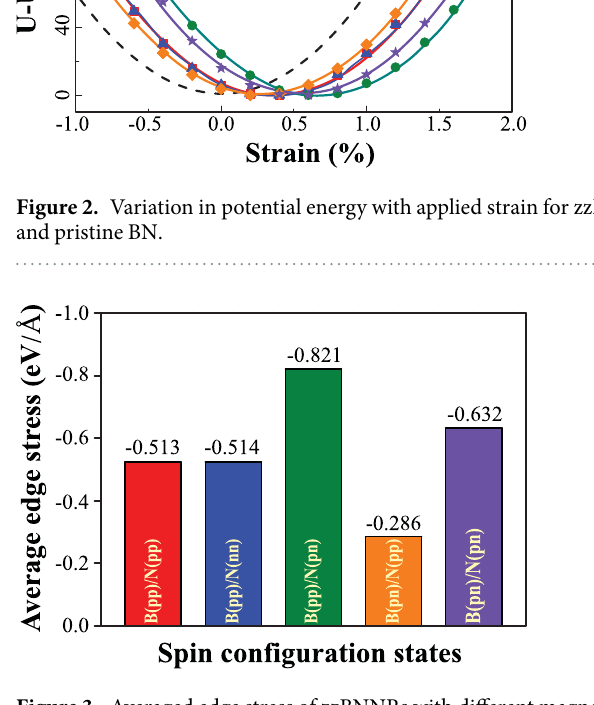
Figure 3. Averaged edge stress of zzBNNRs with different magnetic configurations.